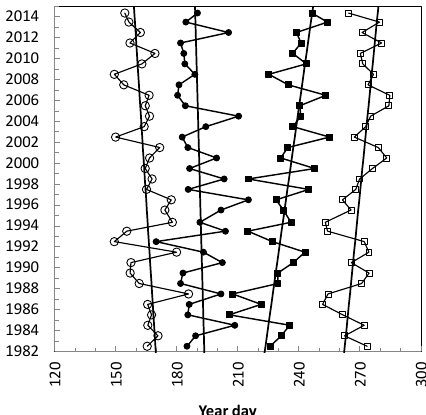
Figure 4. Changes in satellite-detected SST phenology in the Baltic Sea (area indicated in Fig. 1a). The symbols and regression lines are (left to right): first day when 12 ◦ C is reached (DFSST12, open circles), first day when 17 ◦ C is reached (DFSST17, filled circles), last day when 17 ◦ C is reached (DLSST17, filled squares), last day when 12 ◦ C is reached (DLSST12, open